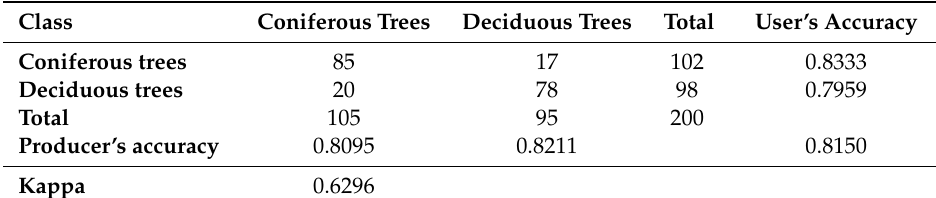
Table 4. Confusion matrix for the orthophoto-based